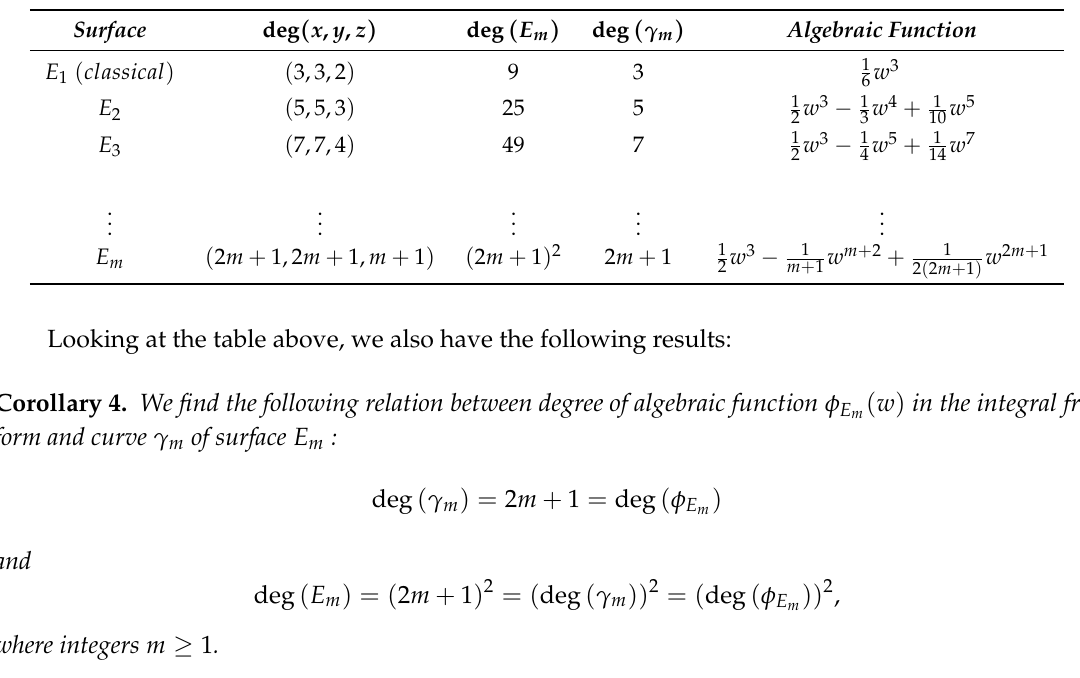
Table 1. Algebraic Enneper minimal surfaces E m , m ≥ 1, m ∈ Z